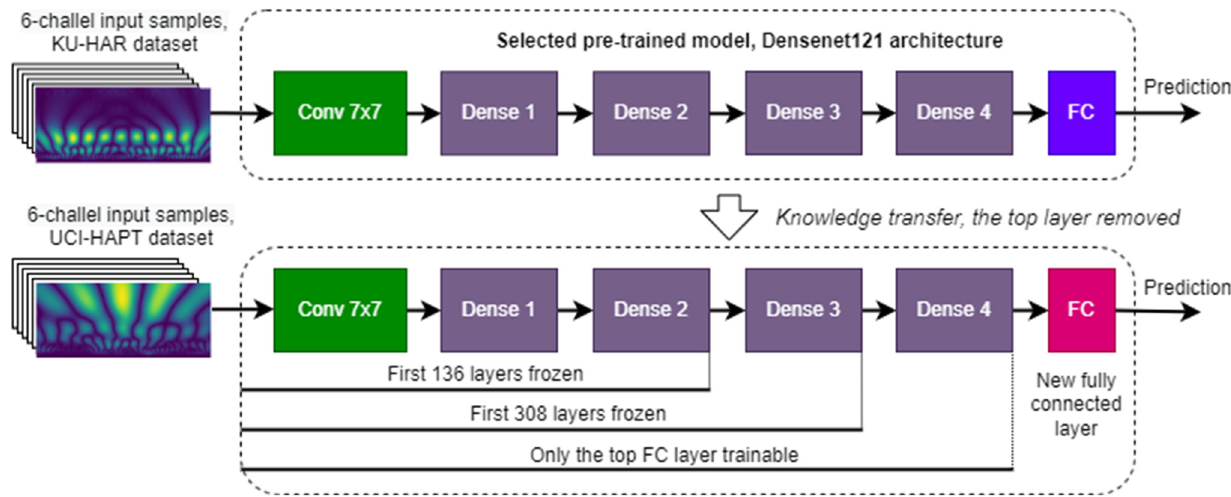
Figure 3. The employed transfer learning methodology.